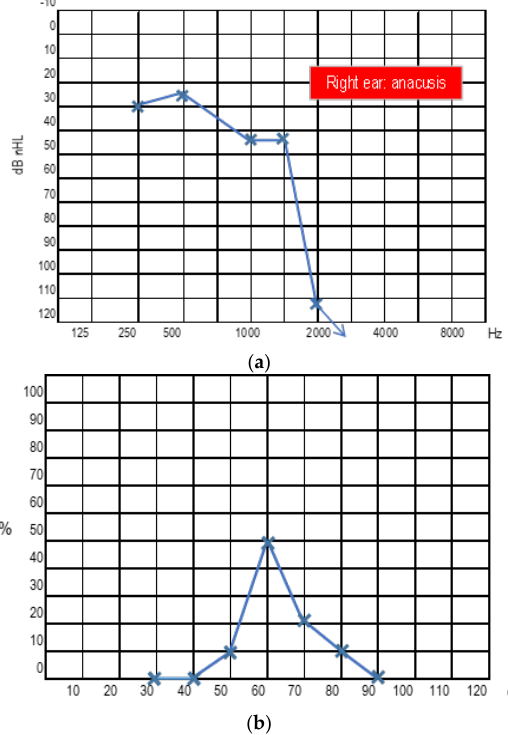
Figure 3. Left ear: pure tone audiometry ( a ) and speech audiometry ( b ) at preoperative evaluation. Right ear: anacusis. The patient underwent right subtotal petrosectomy and EAC (external auditory ca- nal) cul-de-sac closure for intravestibular-intracochlear schwannoma removal with sim-